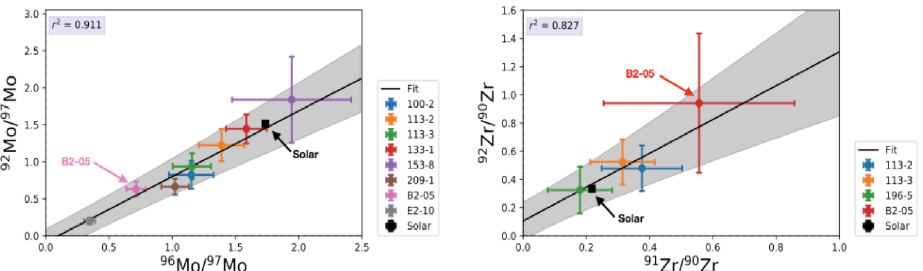
Fig. 2. Mo and Zr three-isotope plots for SiC-X grains (2 σ uncertainties). 2D data fit (line), associated 2 σ errorband (shaded area) and quality of fit (r 2 ) also shown. See [19] for details on grain E2-10 (excluded from this